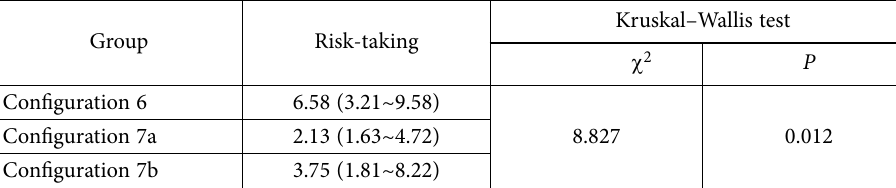
Table 9. A nonparametric test of tertiary industry corporates’ risk-taking